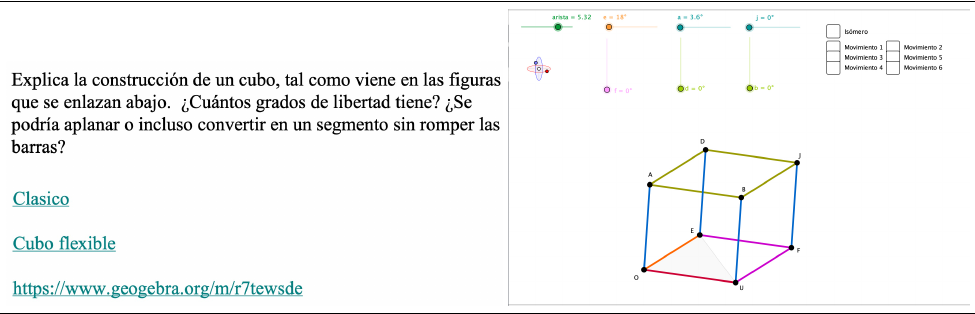
Figure 2. Another task proposed to the students: Explain the construction of a cube as shown in the figures linked below. How many degrees of freedom does it have? Could it be flattened or even made into a segment without being flattened or even made into a segment without breaking the bards?